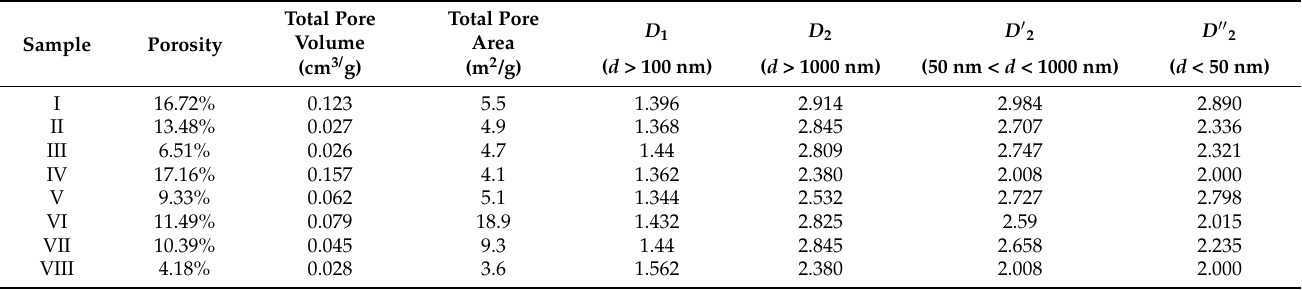
Table 2. Parameters of pore structure for 8 coal samples by MIP